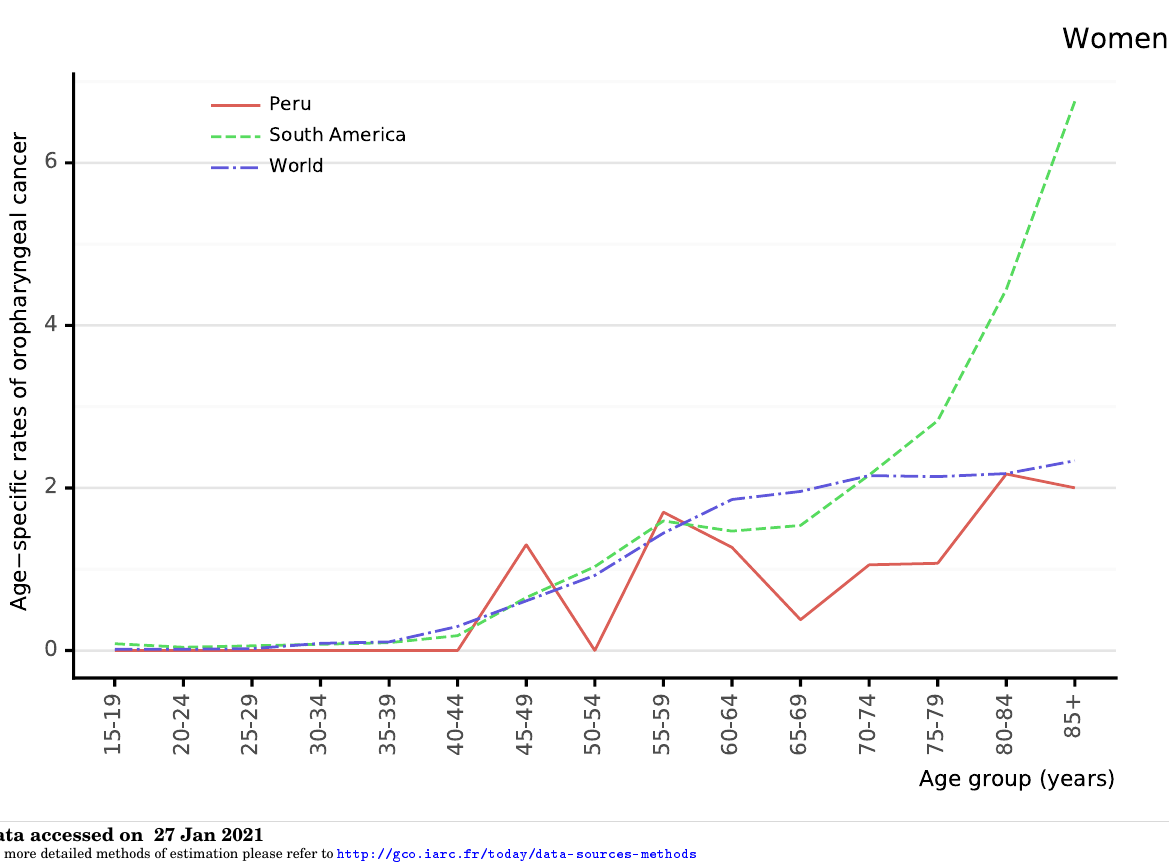
Figure 94: Comparison of age-specific oropharyngeal cancer incidence rates among women by age in Peru, within the region, and the rest of